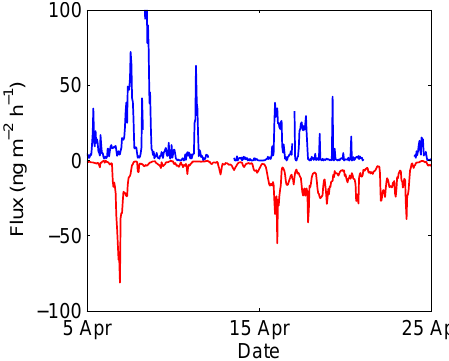
Fig. 1. Time series of net emission (blue) and deposition of oxi- dized mercury by both wet and dry processes (red) for Ny- ˚Alesund in 2008. The net emission was observed (Steen et al., 2009). The deposition of oxidized mercury was simulated by